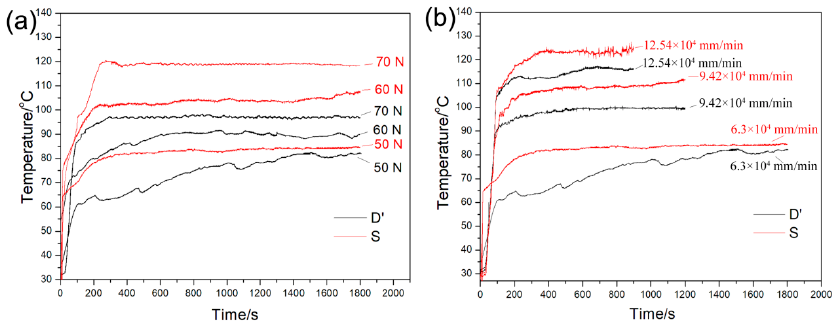
Figure 5. Friction temperature of the ductile iron and carbon steel wheels. ( a ) At a sliding velocity of 6.3 × 10 4 mm/min and under different loads ( b ) with a load of 50 N and different sliding velocities and durations.